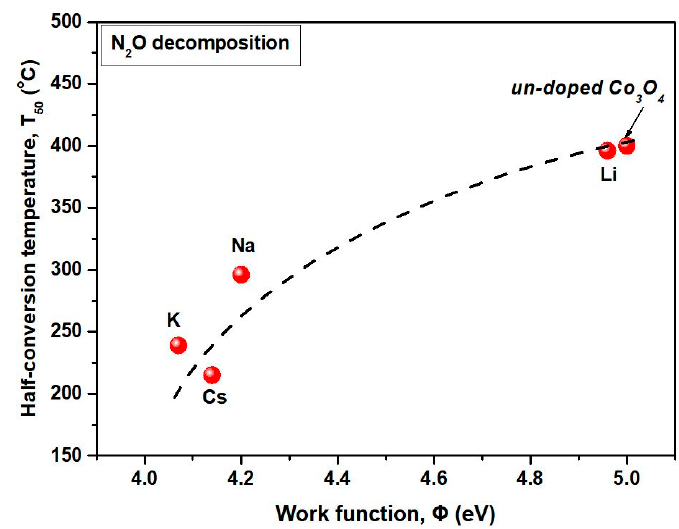
Figure 8. Correlation of half-conversion temperature (T 50 ) with the work function of alkali promoted Co 3 O 4 . Reaction conditions: 5.0% N 2 O; m cat = 300 mg; GHSV = 7000 h − 1 ; alkali coverage = ~2 at/nm 2 . Adapted from Reference [178]. Copyright © 2009, Elsevier.